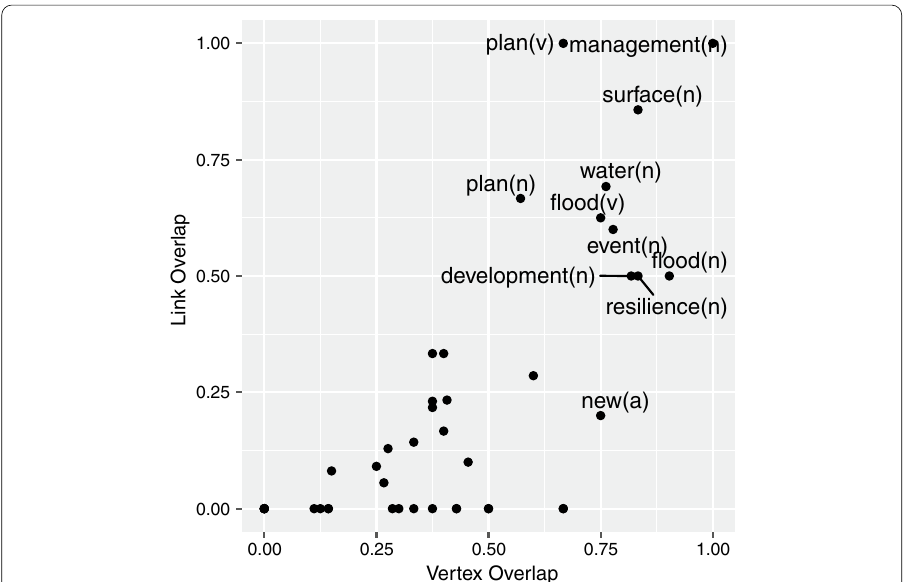
Fig. 4 Top 15% of the most central concepts for local actor a9 along with their vertex and link similarities to